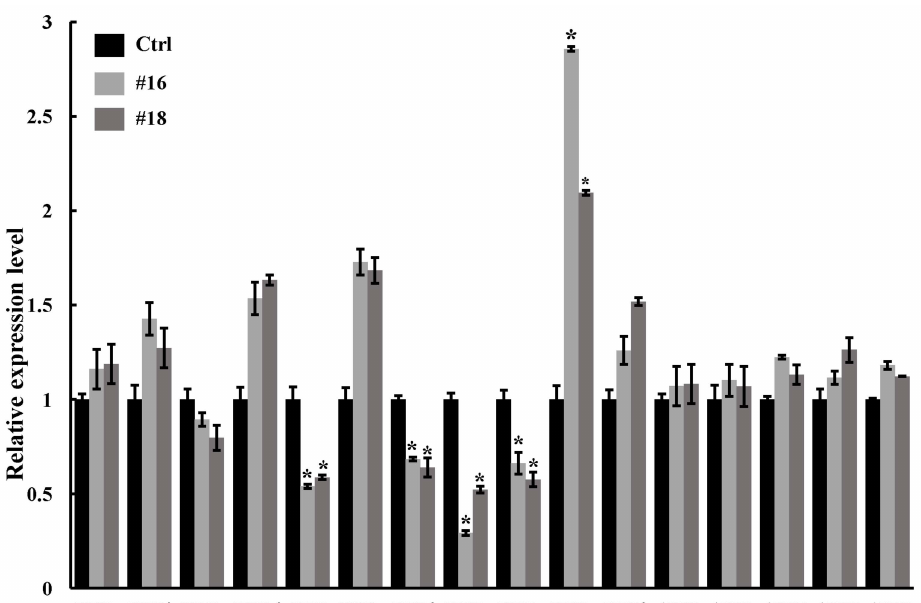
Figure 9. Expression analysis of auxin transport genes. Expression levels of PINs and AUX1 - like genes in three-week-old Ctrl and PtoWUSa -overexpressing poplar plants were detected using qRT-PCR. The expression levels of each gene in Ctrl were set to 1. * indicated the di ff erence between Ctrl and each transgenic line at p < 0.05